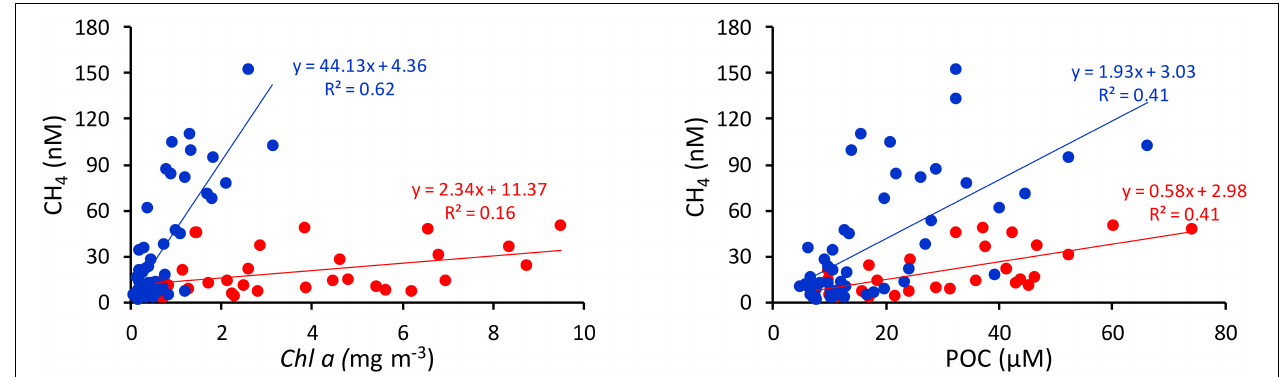
FIGURE 5 | Relationship of CH 4 with POC and Chl a in the nearshore waters of SEAS during summer monsoon (red) and rest of the year (blue).